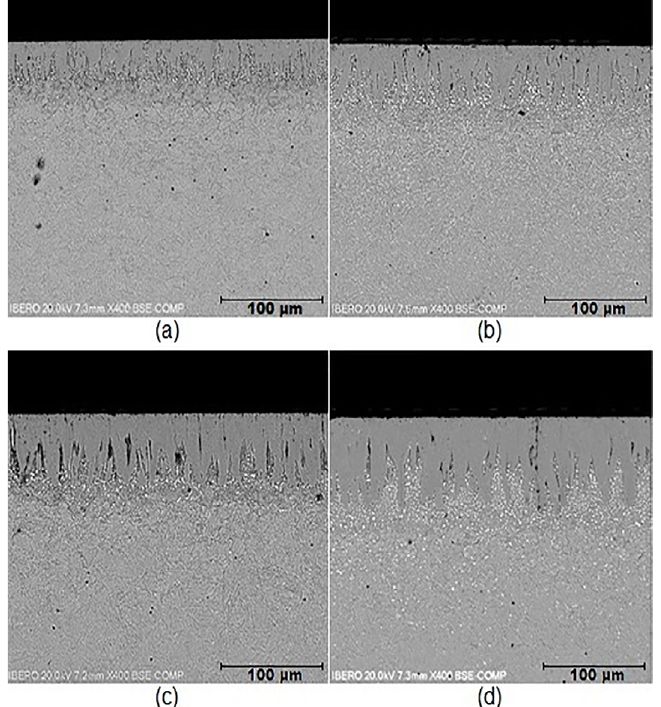
Figure 4. SEM micrographs of the cross-sections of borided AISI S1 steels at 1173 K during different exposure times: (a) 2 h, (b) 4 h, (c) 6 h, and (d) 8 h